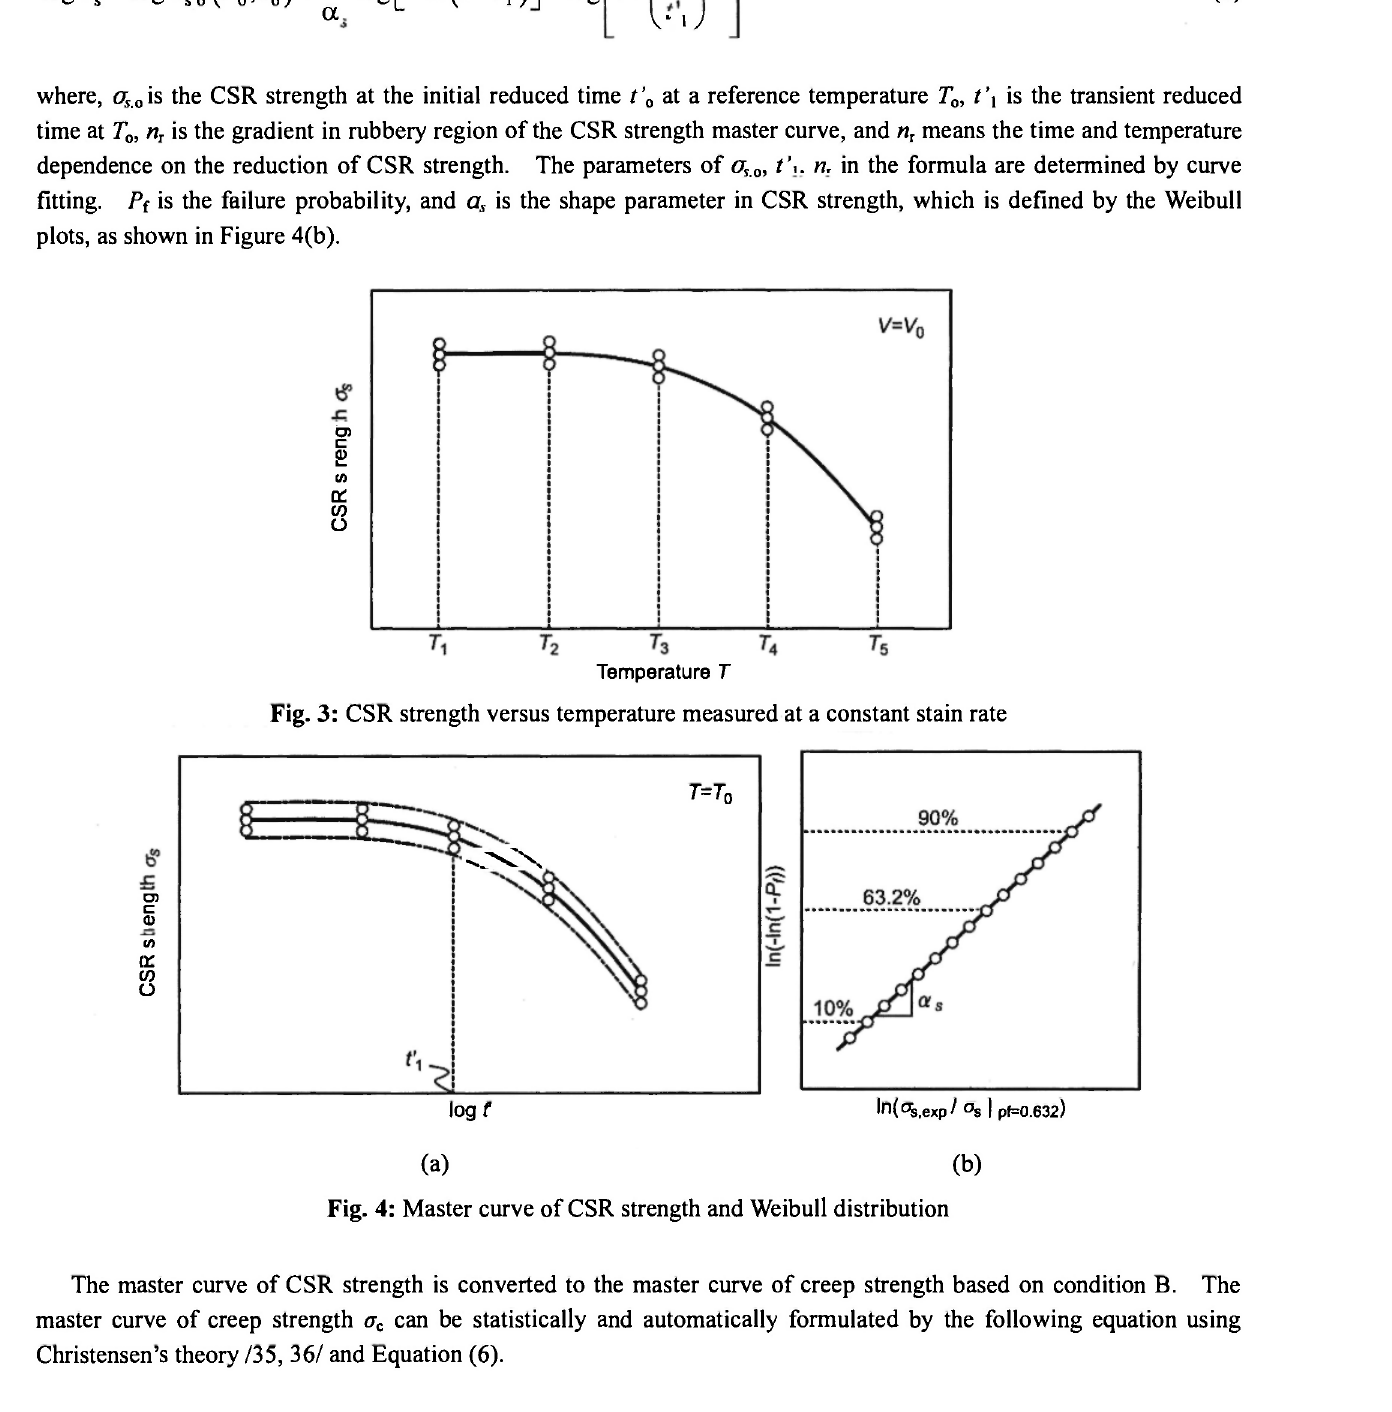
Fig. 4: Master curve of CSR strength and Weibull